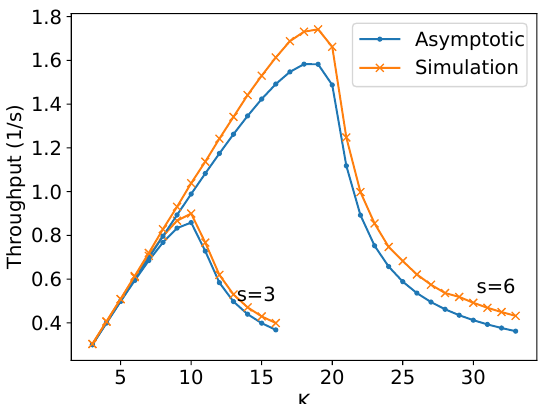
Figure 42. Throughput versus the number of lanes comparison of the simulation on Stage and asymptotic throughput for s ∈ { 3,6 }